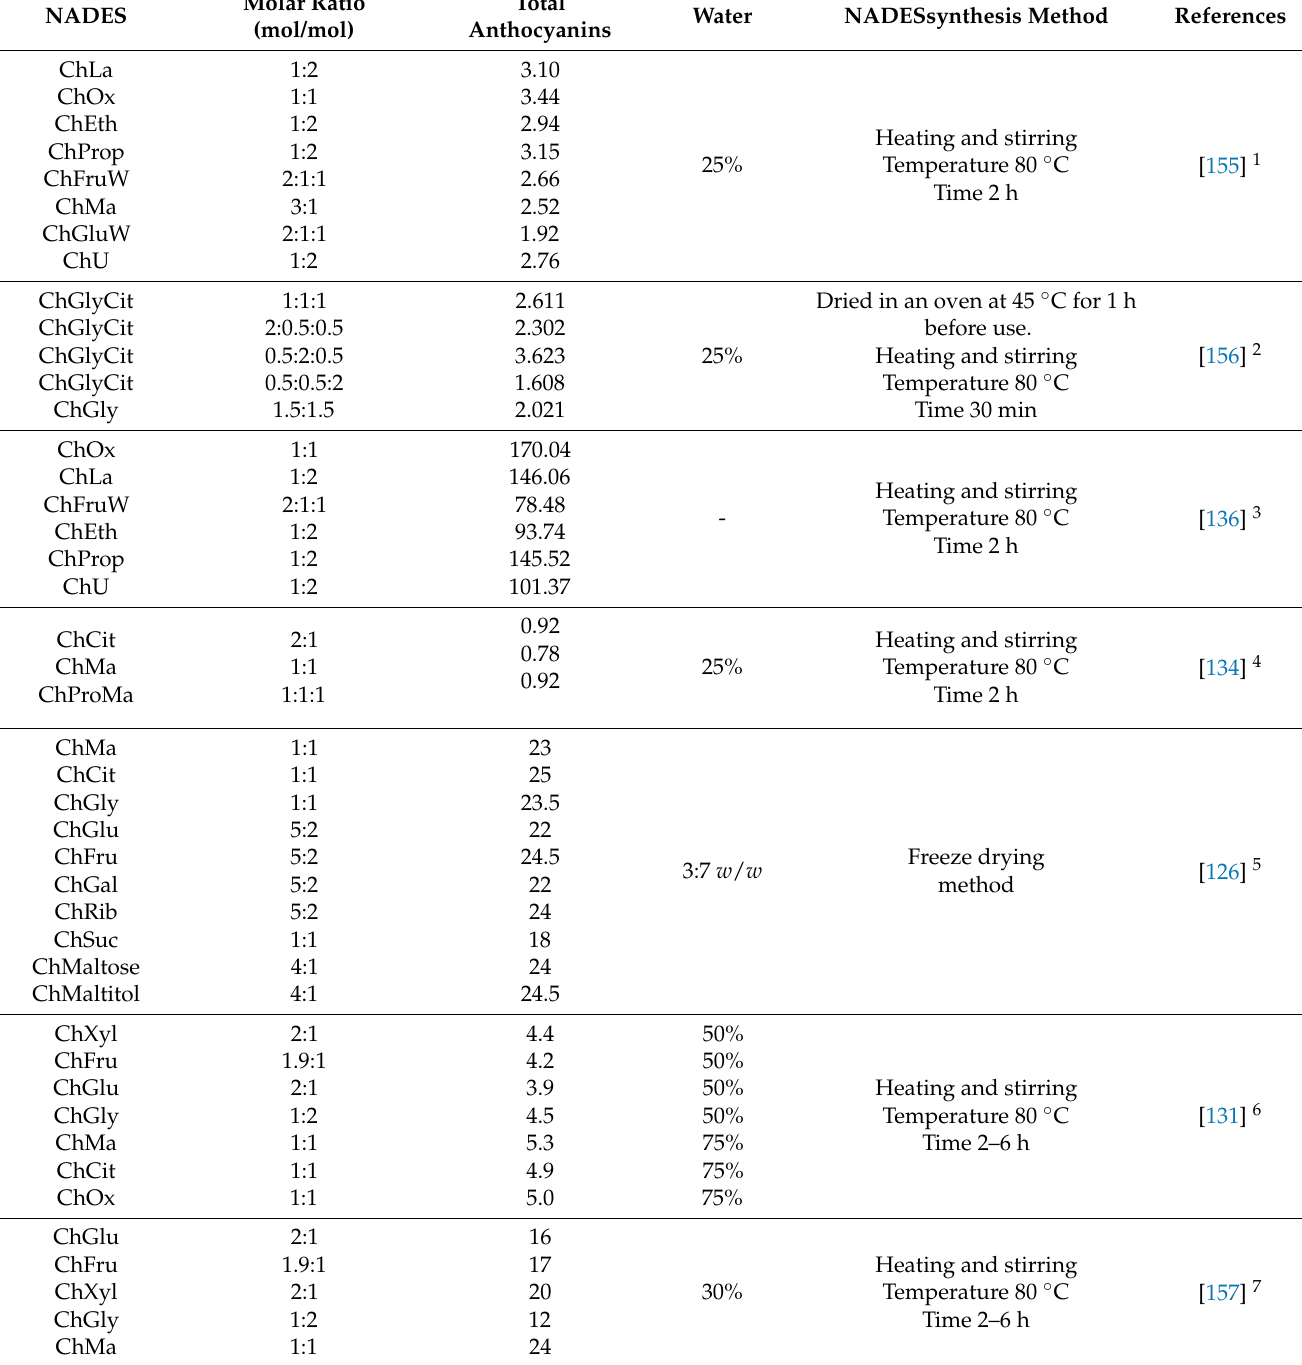
Table 3. Anthocyanin extraction using